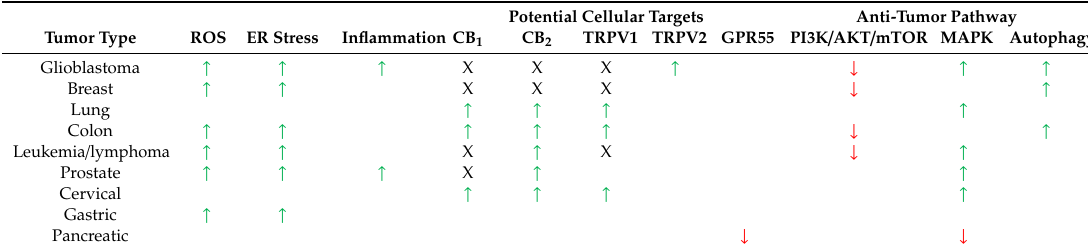
Table 1. The e ff ects of CBD on di ff erent